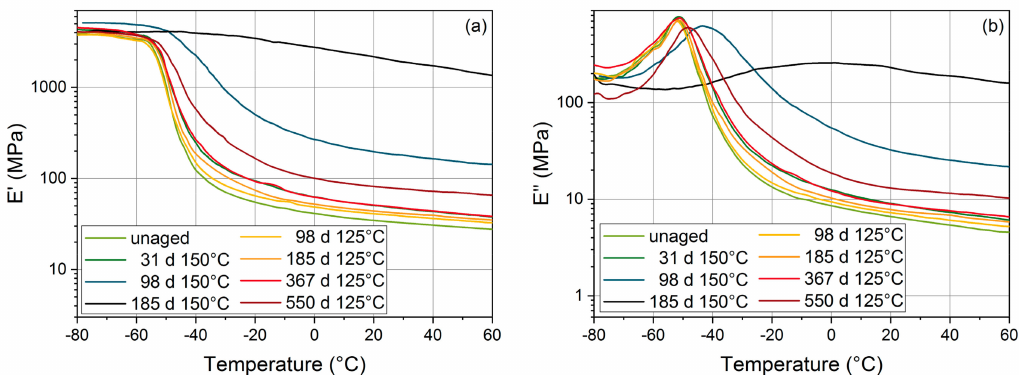
Figure 4. Storage modulus E (cid:48) ( a ) and loss modulus E” ( b ) of ethylene propylene diene rubber (EPDM) vs. temperature measured on sheet material at 1 Hz measurement frequency. Note that the graphs for 31 d at 150 ◦ C and 367 d at 125 ◦ C are almost identical.